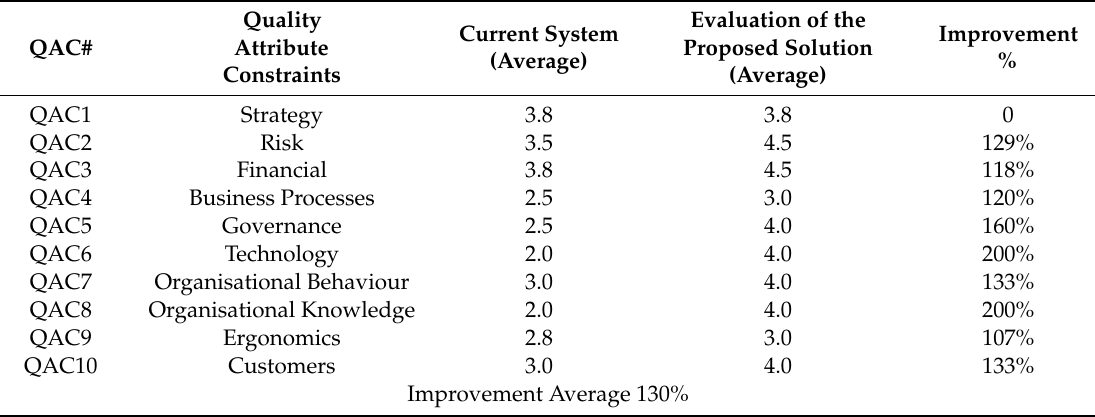
Table 4. Evaluation of the current RPI system and the proposed